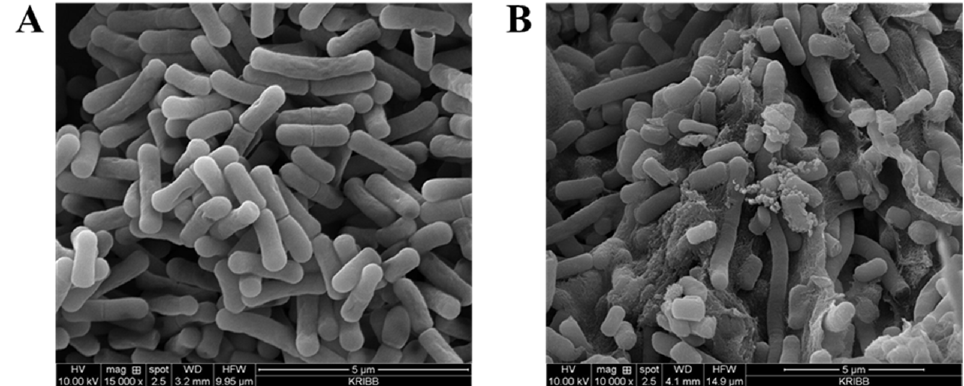
Figure 3. Effect of bile salt incubation of L. fermentum KGC1601 and KCTC 3112 for 3 h at 37 ◦ C on cell morphology as studied under scanning electron microscope (20,000 × ). ( A ) L. fermentum KGC1601, ( B ) L. fermentum